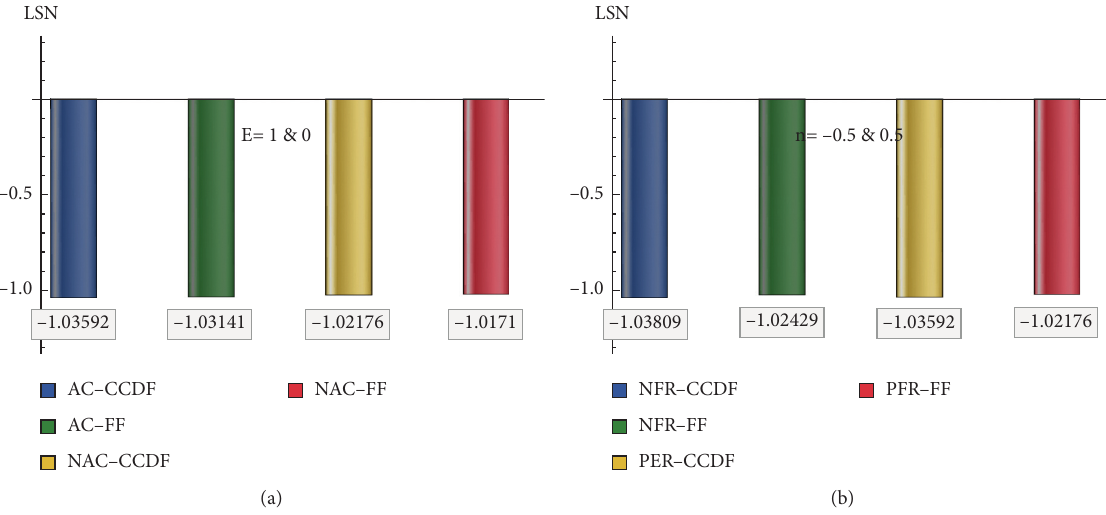
Figure 13: The local Sherwood number on various combinations of E and n of a CCMF and FMF flow of WNF and